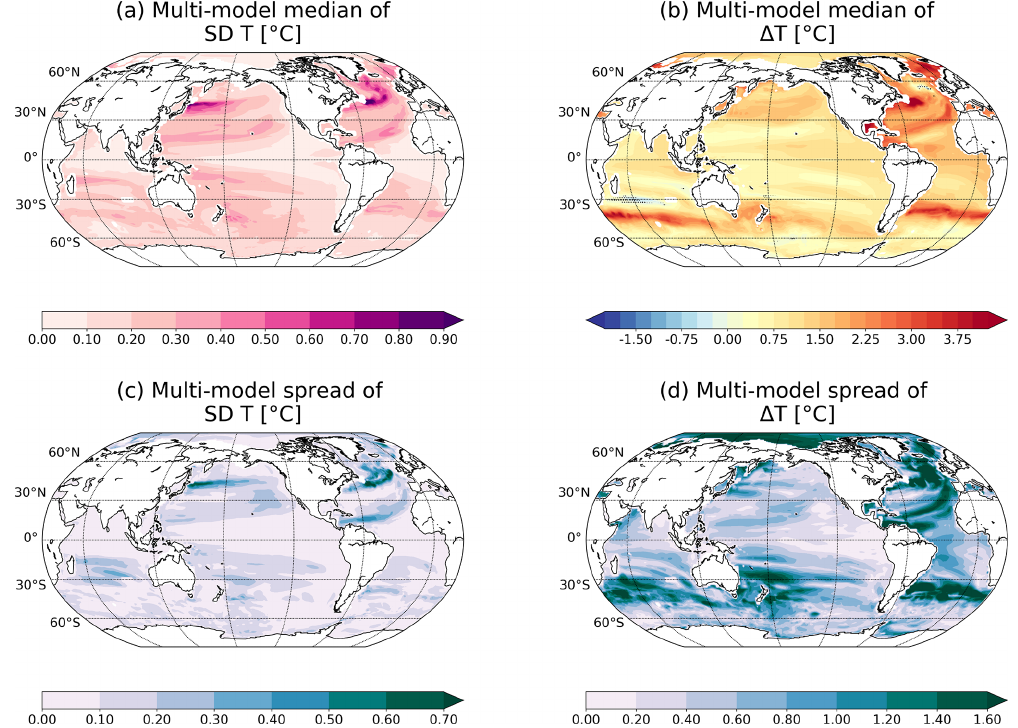
Figure 4. Median (a, b) and spread (c, d) of multi-model natural variability (standard deviation of control simulation; a, c ) and changes by the end of the 21st century (b, d) of ocean temperature between 200 and 600m. The individual responses for each model are shown in Figs. S3 and